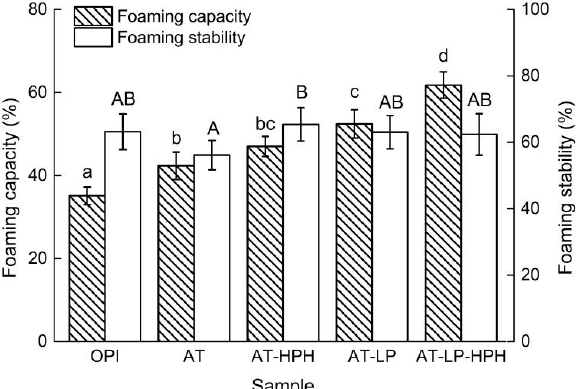
Figure 4. Foaming properties of OPI and the modified samples. Different lowercase and uppercase letters represent significant differences at p < 0.05. letters represent significant differences at p <